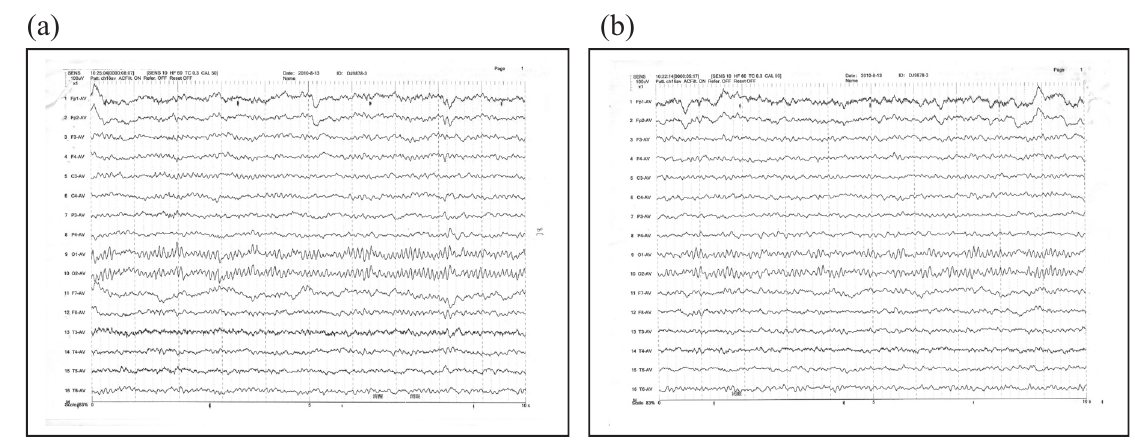
Figure 4. Representative EEG segments of the child 10 days after the procedure. A, Awake with closed eyes. B,